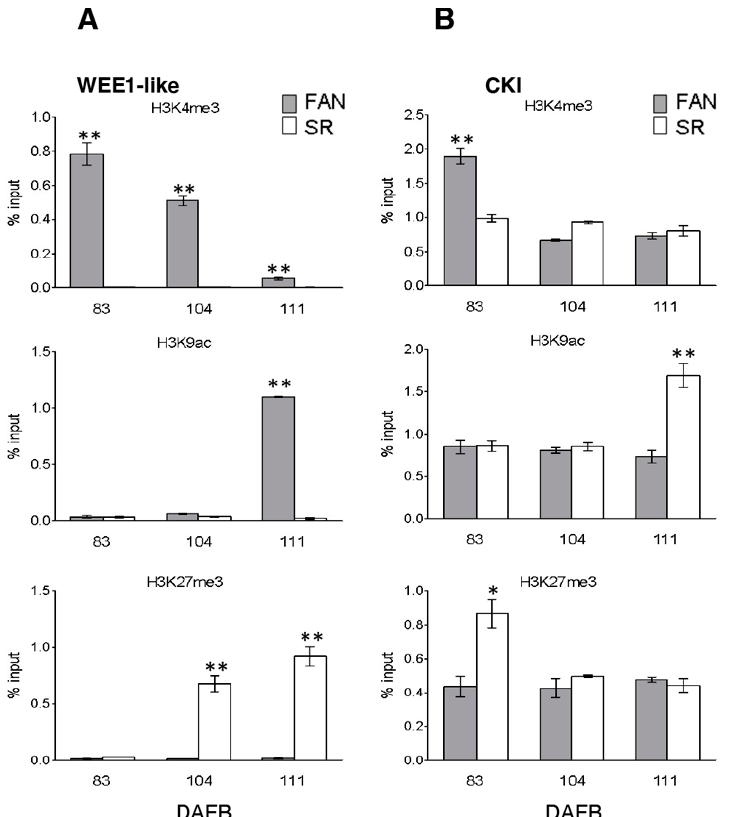
Figure 5. Chromatin mark analysis at target genes controlling endoreduplication during the growth period of FANTASIA (FAN) and slow ripening (SR) genotype fruits. Histone modification analysis at WEE1 (Prupe.8G256300, Panel A ) and CKI (Prupe.1G006300, Panel B ) loci by real-time PCR quantification of ChIPed DNA immunoprecipitated with α -H3K4me3, α -H3K9ac and α -H3K27me3 antibodies on chromatin extracted from FAN (grey bars) and SR (white bars) mesocarp tissue at 83, 104, and 111 DAFB. Data are reported as percentage of chromatin input, normalized on background signal (measured by omitting antibody during ChIP procedure), and three PCR repetitions for each ChIP assay. Standard errors are reported. Asterisks indicate statistically significant changes: * = p ≤ 0.05, ** = p ≤ 0.01. DAFB: Days after full bloom.